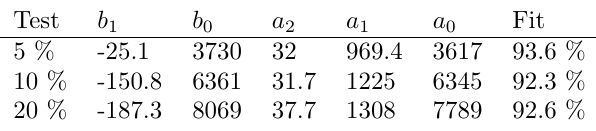
Figure 11: Example in 50% negative offset.